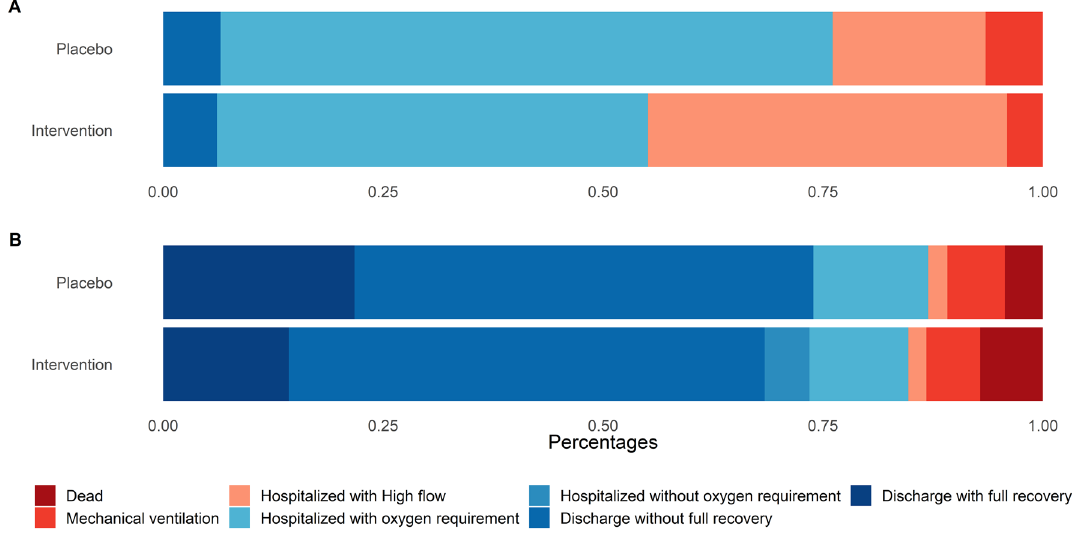
Figure 2. Clinical progression scale at baseline ( A ) and by 14 days ( B ). Ordinal scale, day